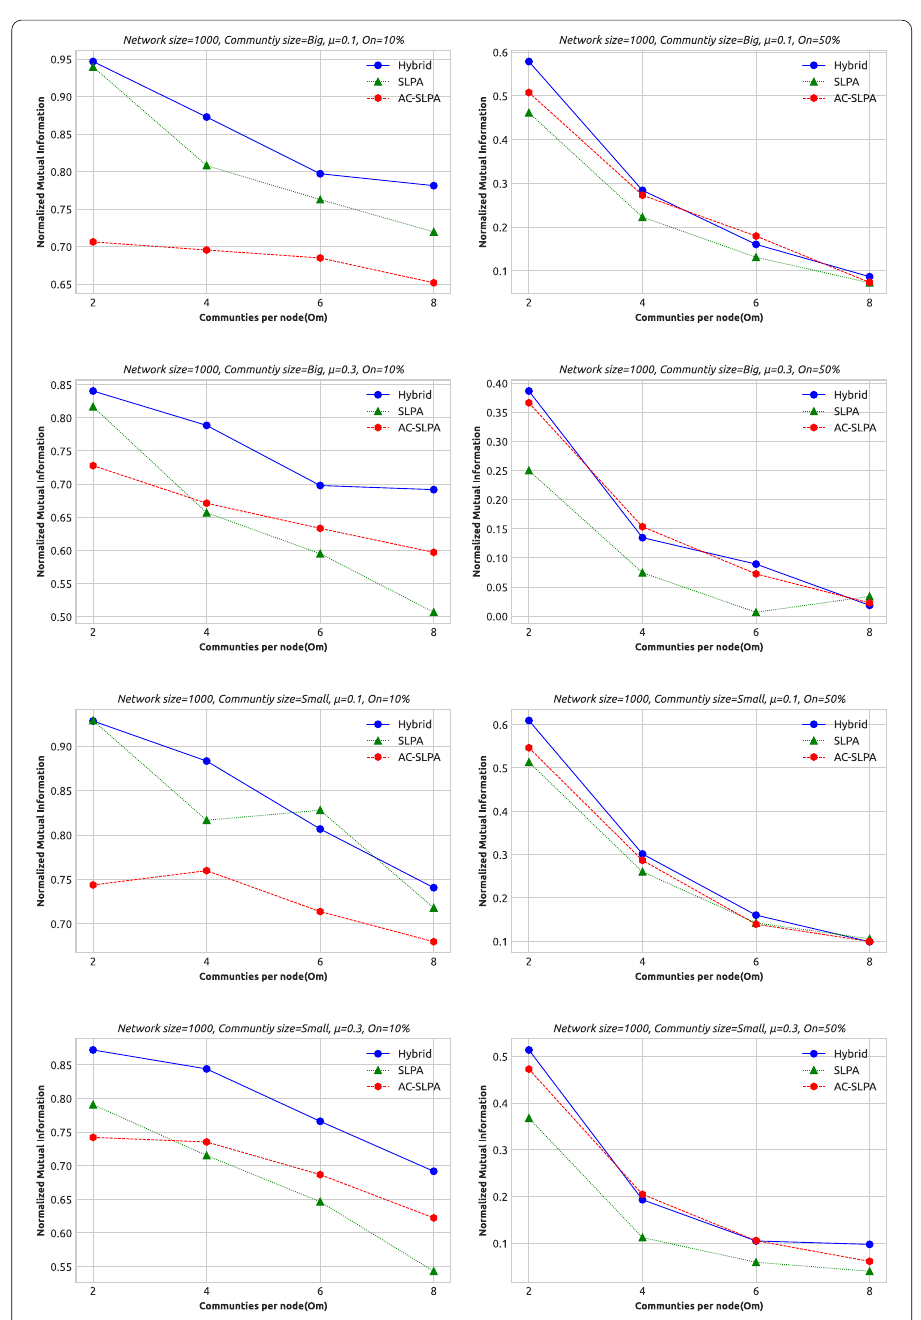
Fig. 10 Performance of AC-SLPA using the hybrid cleaning process compared to SLPA and AC-SLPA with noisy pairwise constraints on small synthetic networks , containing both small and large communities, where the mixing parameter µ varies from 0.1 to 0.3. NMI values are plotted against the number of communities per node ( O m